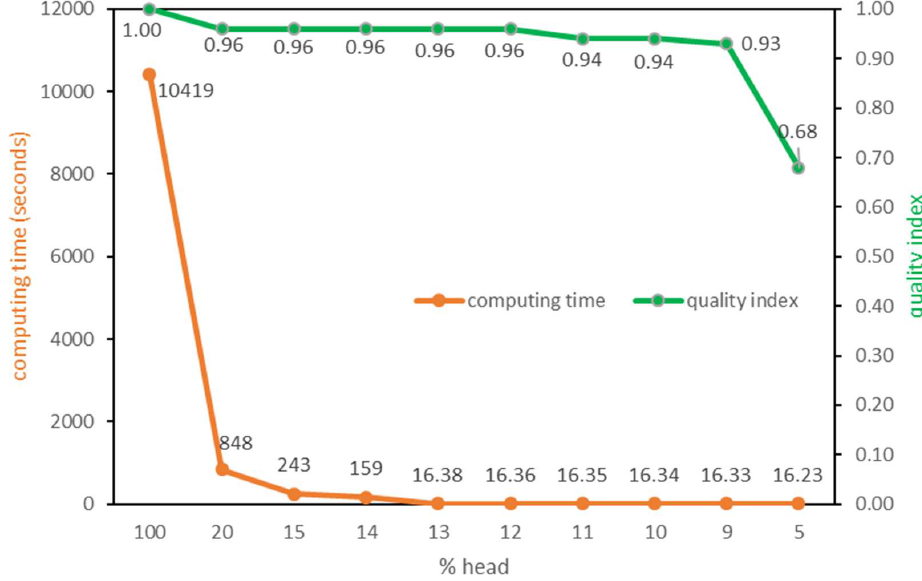
Figure 4. Performance of flowAMOEBA with head/tail breaks.